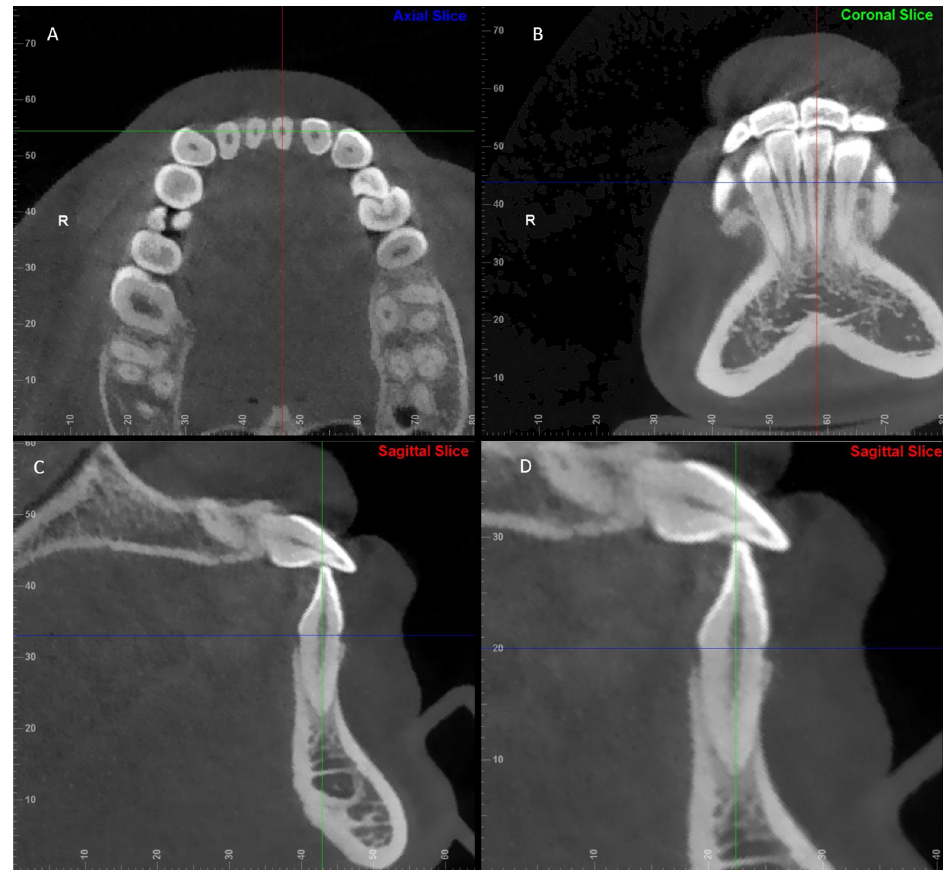
Fig 1. A detailed procedure for locating the measurement plane. Three guidelines with different colors representing the correlated planes as follows: blue, axial plane; red, sagittal plane; green, coronal plane. A, Adjust the location of the axial plane by passing the blue guideline through the CEJ of the selected anterior tooth in both the coronal and sagittal views; then, rotate the green guideline until the intersecting line is the shortest. B, Rotate the red guideline until it passes through the root apex and the midpoint of the incisal margin. C, Rotate the green guideline until it passes through the root apex and the midpoint of CEJ line. D, To ensure precise and accurate identification of the anatomic structures, the largest labiolingual section of the anterior tooth displayed in the corrected sagittal view was chosen as the measurement plane.